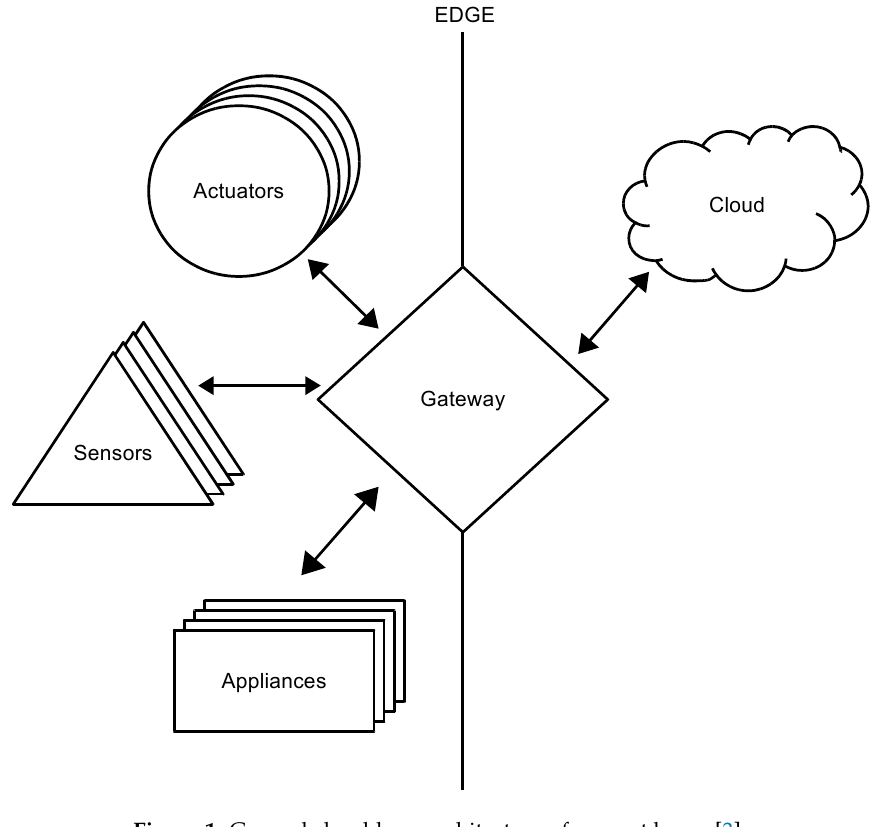
Figure 1. General cloud-base architecture of a smart home [3].